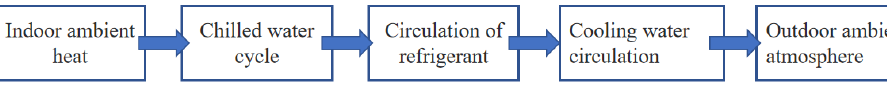
Figure 3. Heat transfer diagram.